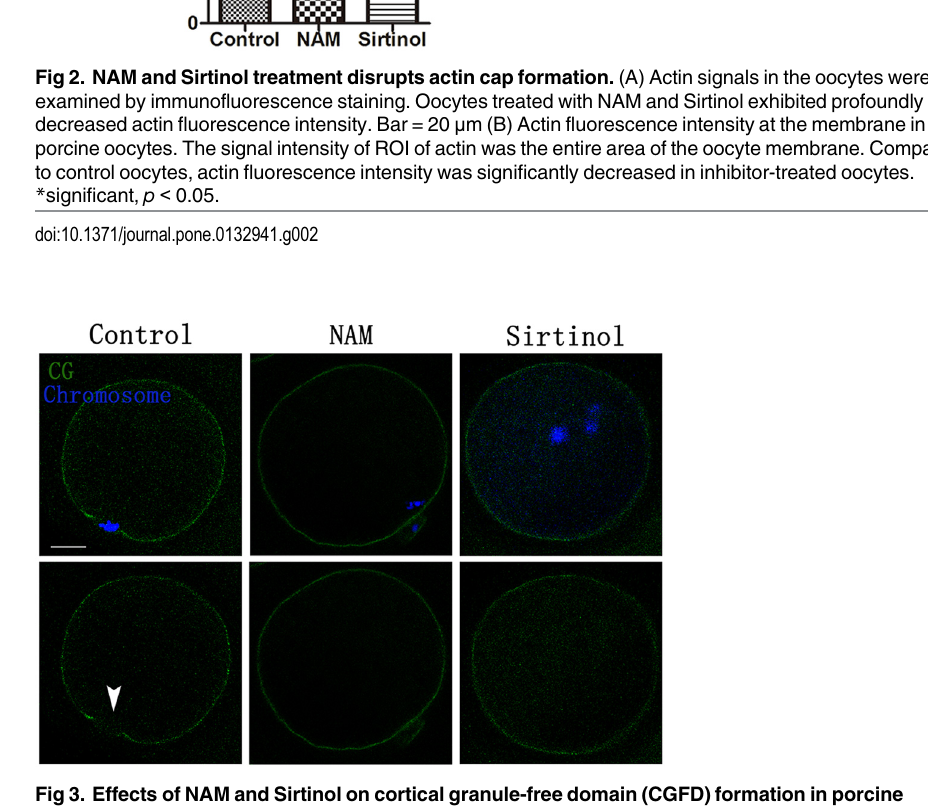
Fig 3. Effects of NAM and Sirtinol on cortical granule-free domain (CGFD) formation in porcine oocytes. In the control group, cortical granules (CGs) were absent at the cortex near the site of polar body extrusion in MI oocyte. However, in the treatment group, cortical granules were distributed uniformly across the entire cortex. CGFD formation was failed to observation. The arrow indicates a CGFD. Green, CGs; blue, chromatin. Bar = 20 μ m.